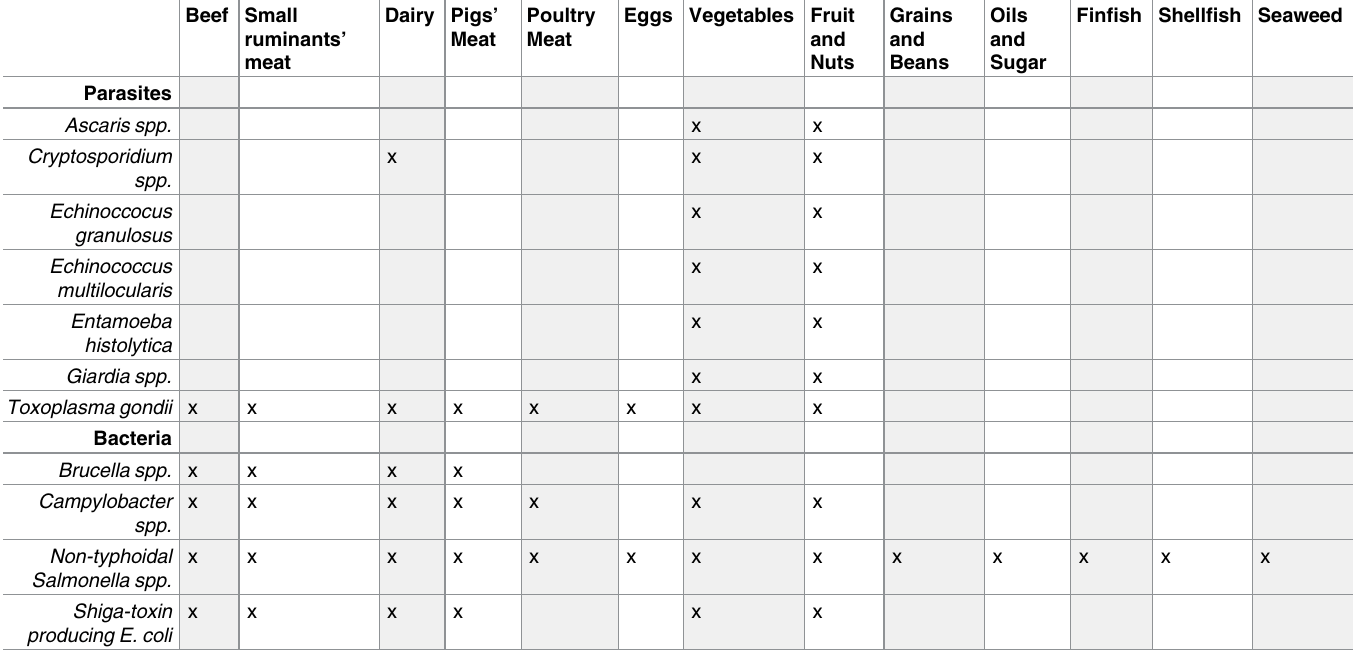
Table 1. Food exposure routes elicited in WHO global burden of foodborne disease expert elicitation by pathogen *